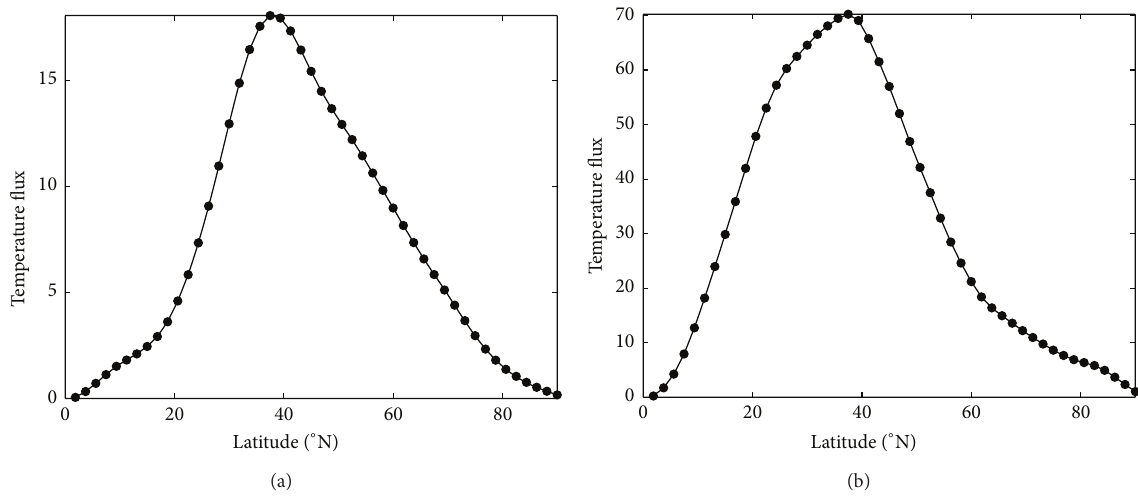
Figure 6: Mean meridional eddy heat flux (mKs −1 ) at (a) 333 hPa and (b) 667 hPa of the NH wintertime 550-year